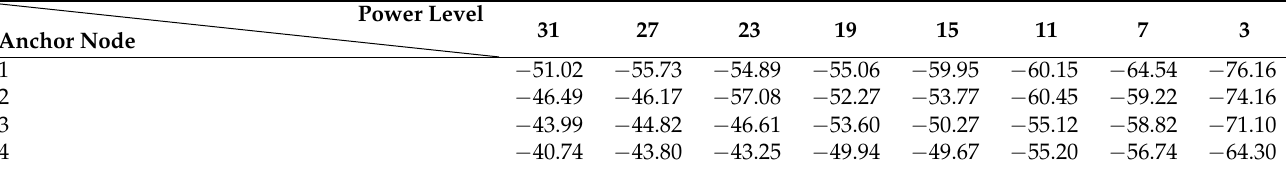
Table 2. Nominal transmission power A of anchor nodes in dBm.